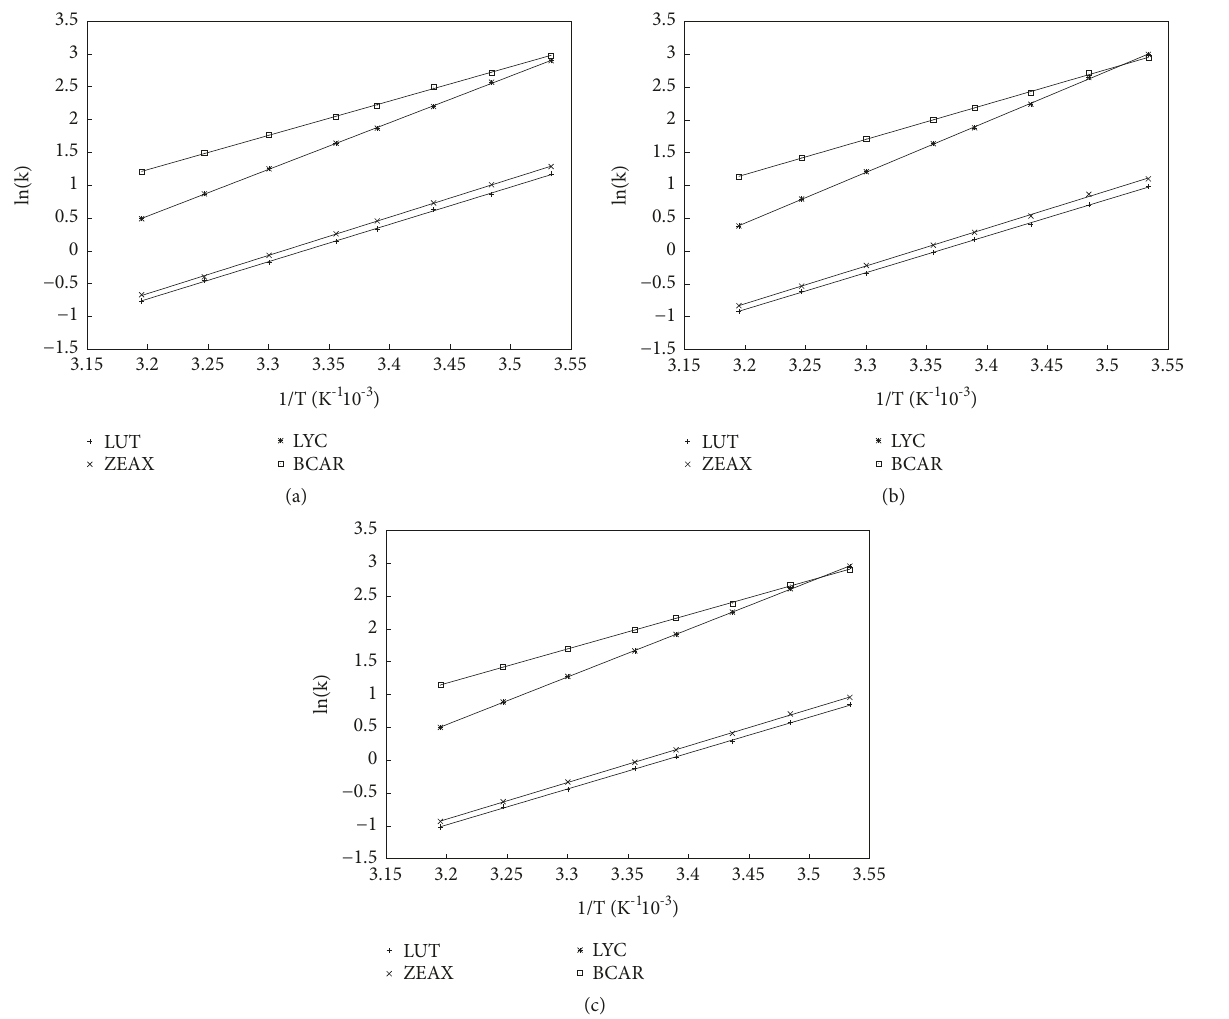
Figure 2: Van’t Hoff plots at different MP composition: (a) ACN=28.5% v/v; (b) ACN=38% v/v; (c) ACN=47.5%